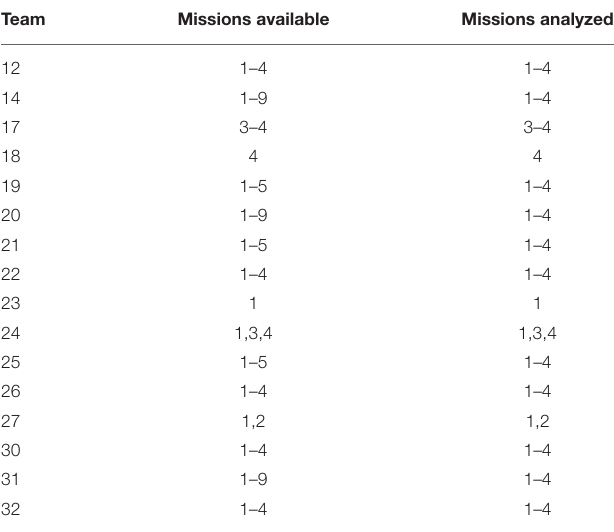
TABLE 2 | Transcribed speech communication data available and analyzed from teams and missions. Team Missions